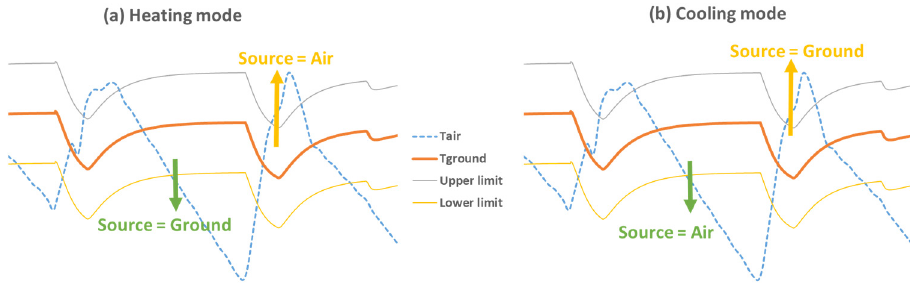
Figure 7. Selection of the source concerning the air and ground temperature [27].